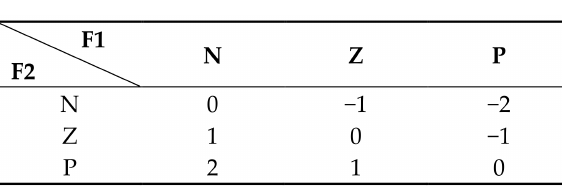
Figure 2. Fuzzy controller.